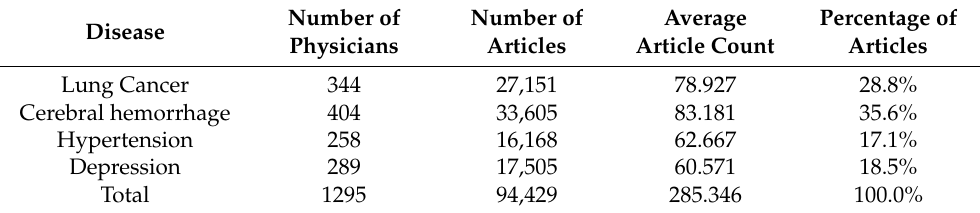
Table 2. Descriptive Statistics for Physicians and Popular Science Articles.